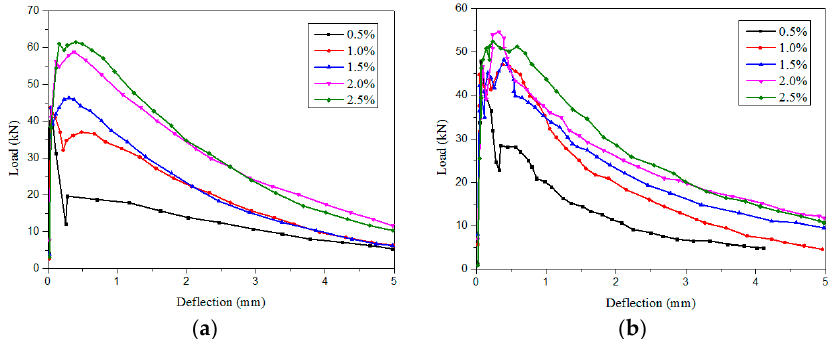
Figure 16. Effects of the SFs content and type on the load – deflection curve [84]. ( a ) Micro- straight SFs (%), ( b ) hooked-end SFs (%).